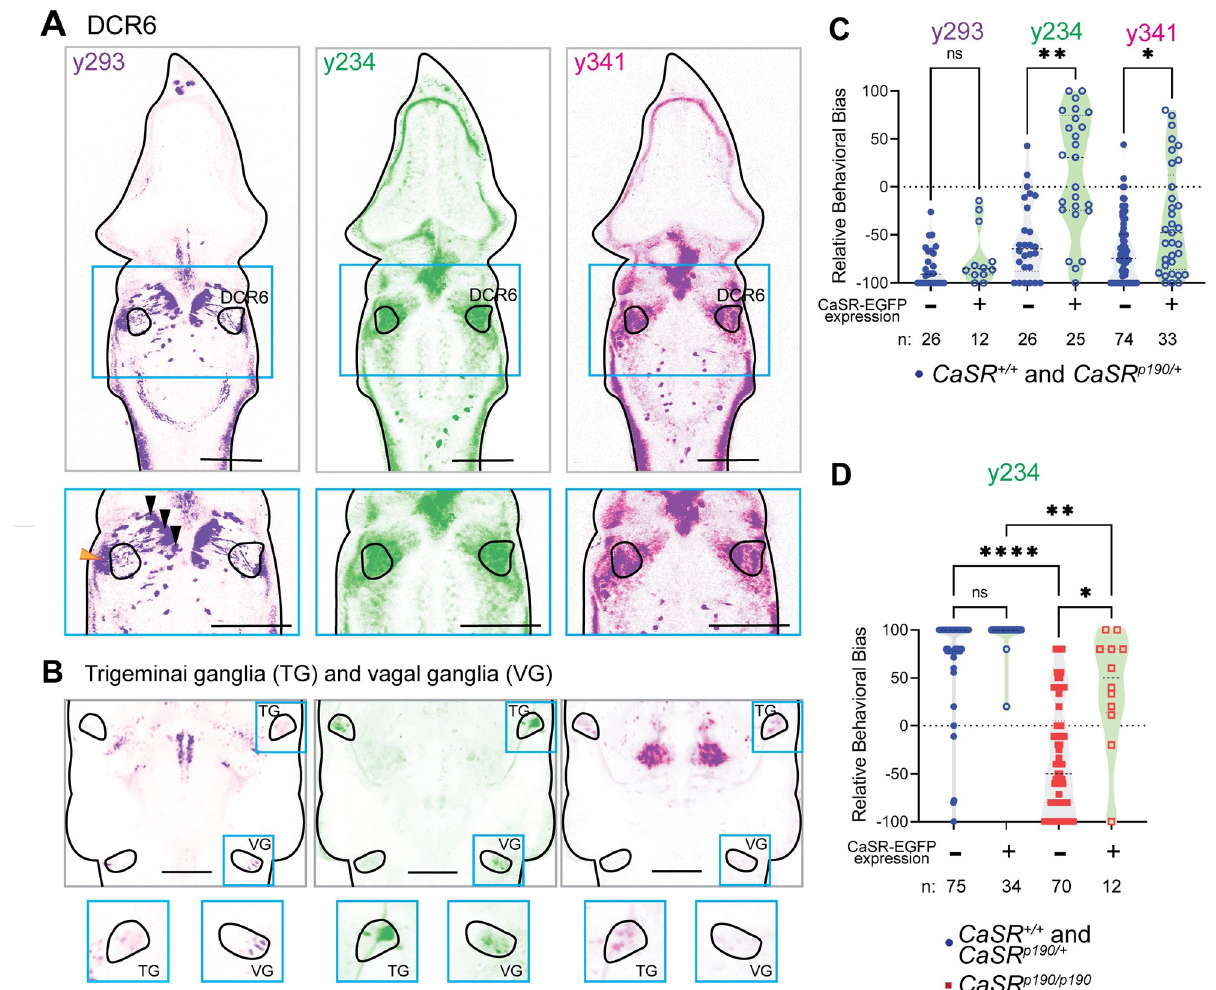
Fig 5. Example validation of a single Gal4-defined brain region as a mediator of a genetic behavioral phenotype. A) Expression patterns of the y293 (purple), y234 (green), and y341 (magenta) Gal4s relative to the DCR6 in Slice 122 of ZBrain 2.0 (https://zebrafishatlas.zib.de/lm) [8, 26]. Scale bars are 100 um. Below, enlarged images of the DCR6. The y293 Gal4 labels apparent cell bodies of a population medial to the DCR6 (black arrowheads) that project through the DCR6 and terminate in a region lateral to the DCR6 (orange arrowheads). However, cell bodies within the DCR6 are labeled only sparsely. By contrast, the y234 and y341 Gal4s both label cell bodies within the DCR6 and immediately surrounding it, y234 to a slightly greater extent than y341. B) Maximum projections from ZBrain slices 12–64 (ventral portion of the brain) in the y293 (blue), y234 (green), and y341 (magenta) Gal4s. All three Gal4s drive expression in the trigeminal ganglion (TG), while only y293 and y234 drive expression in the vagal ganglion (VG). Scale bar = 100 um. C) CaSR overexpression escape-shifted phenotype is exhibited by GFP+ y234; UAS : CaSR-EGFP ; CaSR sibling ( CaSR +/+ and CaSR p190/+ ) larvae responding to a low-intensity acoustic stimulus [19]. D) Partial rescue of CaSR loss-of-function phenotype in sorted GFP+ y234; UAS : CaSR-EGFP ; CaSR p190/p190 larvae responding to a strong acoustic stimulus. CaSR sibling ( CaSR +/+ and CaSR p190/+ ) larvae in blue; CaSR p190/p190 mutant larvae in red. Data from Panel D and some data from Panel C also appear in Shoenhard, Jain, and Granato [19].